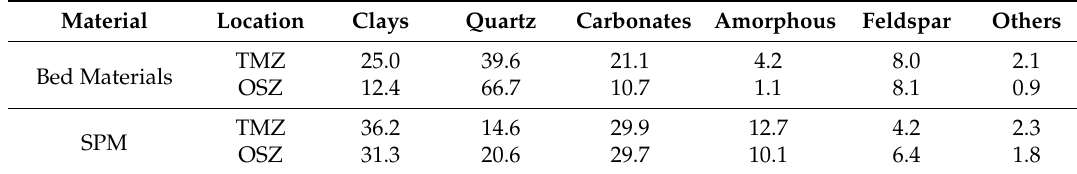
Material Location Clays Quartz